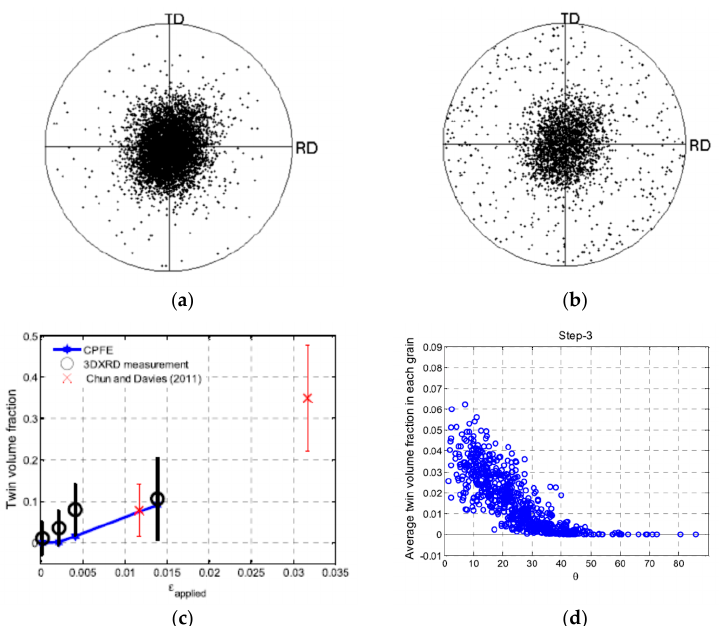
Figure 28. Effect of twinning on texture: ( a ) The { 0002 } pole figures at a tensile strain of ε = 0% (Step- 1), ( b ) the { 0002 } pole figures at a tensile strain of ε = 0.4% (Step-3), ( c ) twin volume computed by CPFE versus the measured twin fraction, ( d ) variation of predicted twin volume versus misorientation between normal to the basal plane of the grain and loading direction predicted by CPFE at a tensile strain of ε = 0.4% (After Abdolvand et al.